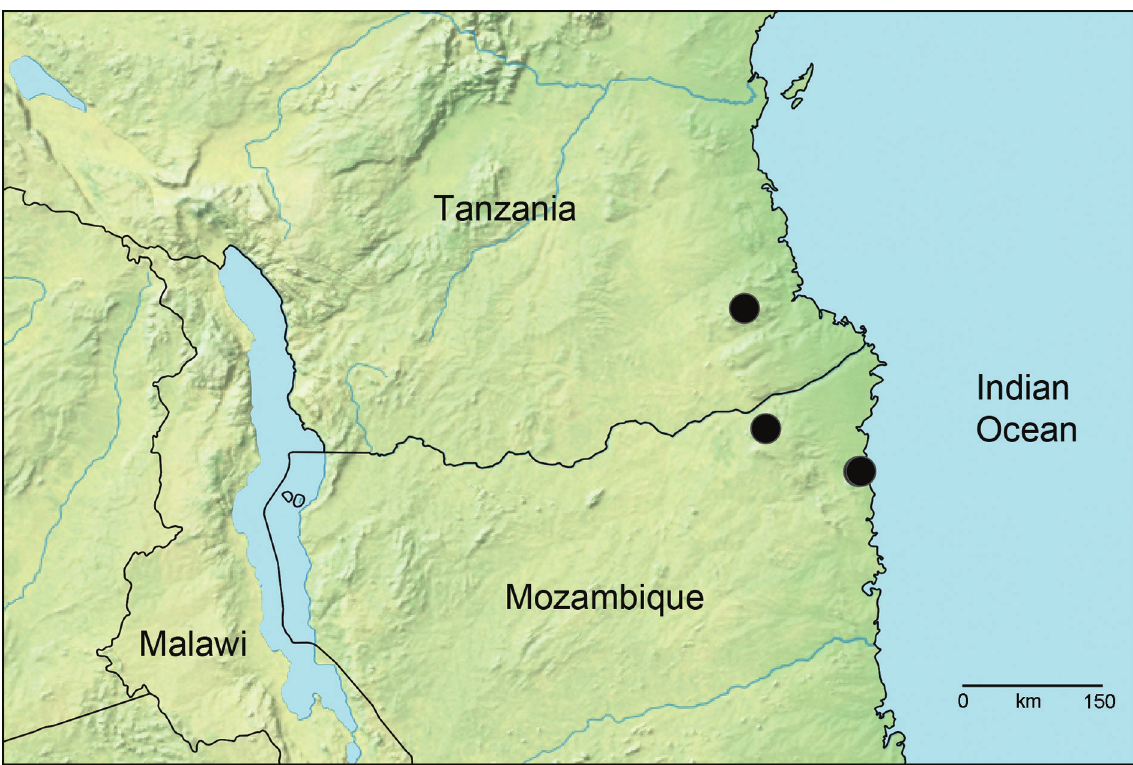
Fig. 3. Distribution of Cladoceras rovumense I.Darbysh., J.E.Burrows & Q.Luke sp.